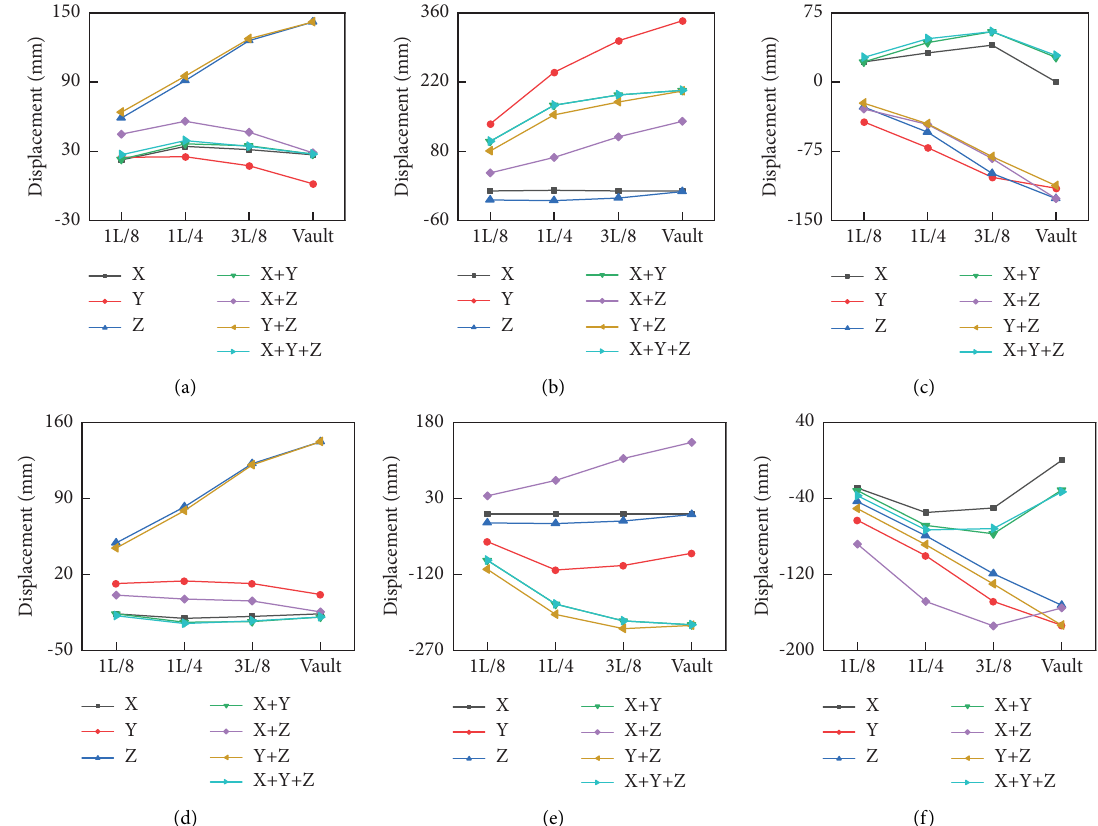
Figure 7: Upper chord displacement diagram under multidimensional excitation. (a) X direction ( N max), (b) Y direction ( N max),